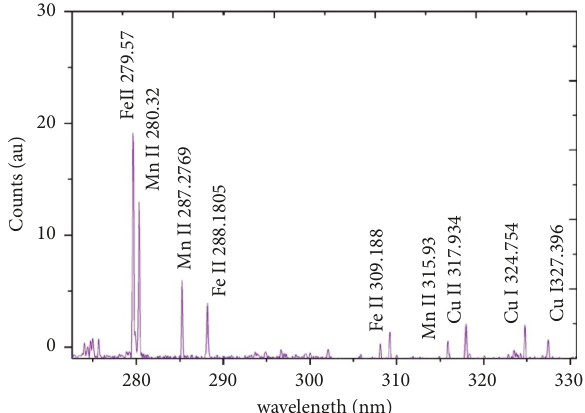
Figure 2: Example of a laser-induced breakdown spectroscopy spectrum of liver cancer tissue showing the lines of copper, manganese, and iron identified in the spectral region of